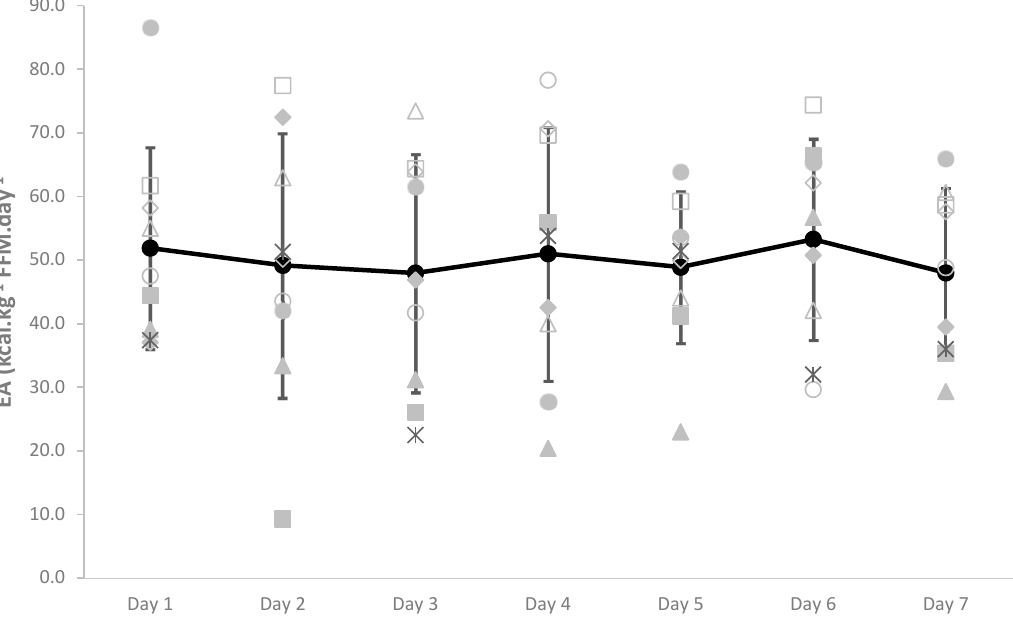
Figure 1. Within and between female participant daily variation in EA (kcal · kg − 1 FFM · day − 1 ). Daily mean ± SD EA for all participant is denoted in bold. Light gray dots represent individual participant data.